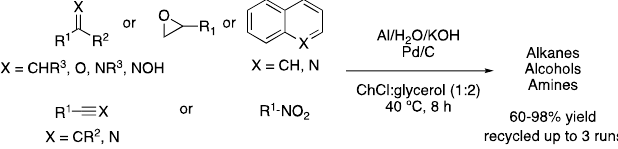
Figure 7. Hydrogenation using in situ generated H 2 from Al and H 2 O.